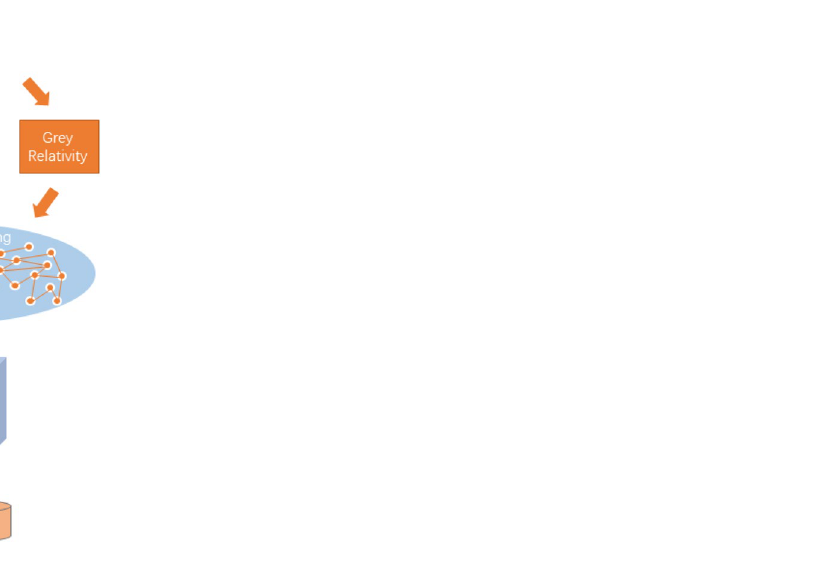
Figure 1. Feature selection flow